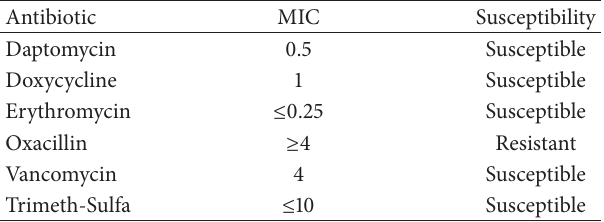
Table 2: Blood culture results and susceptibility profile for the